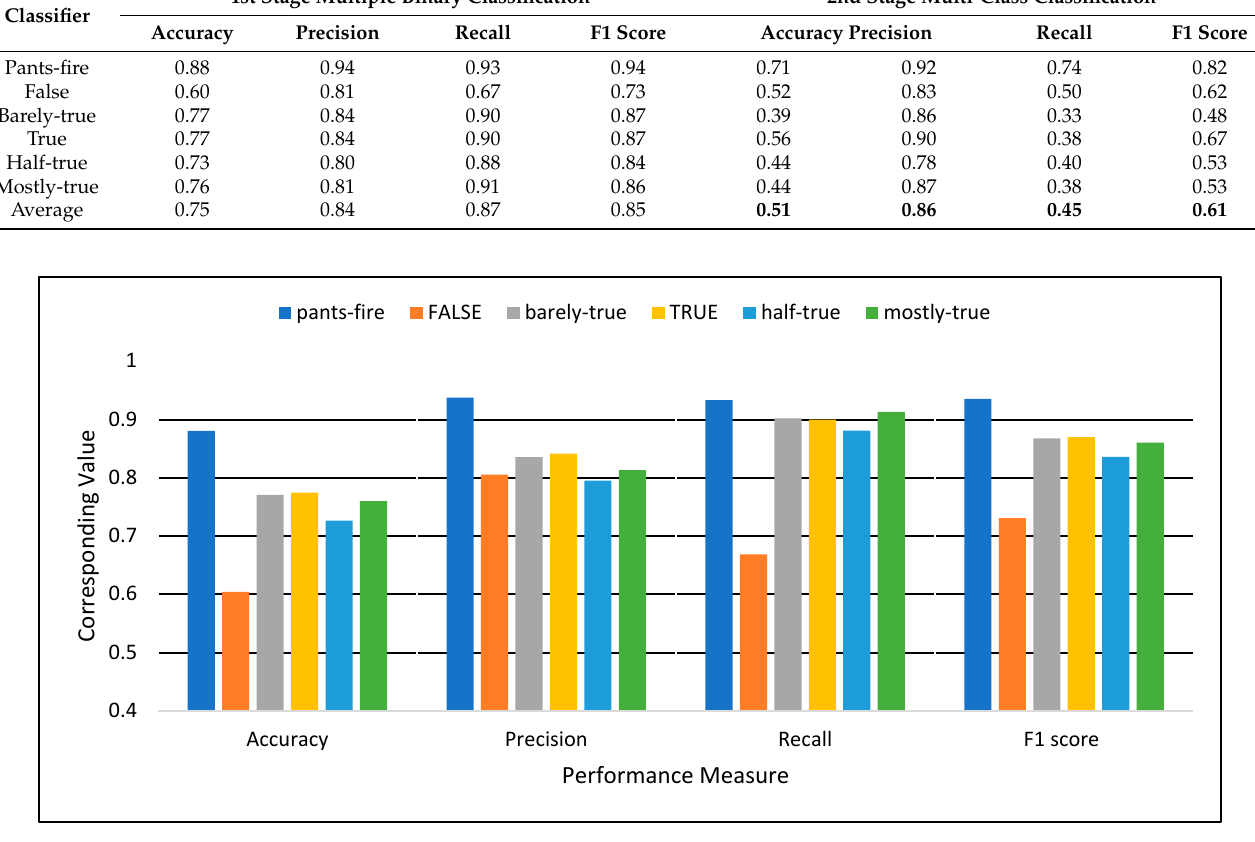
Figure 6. The Performance of the Multiple Binary Classification (1st Stage).